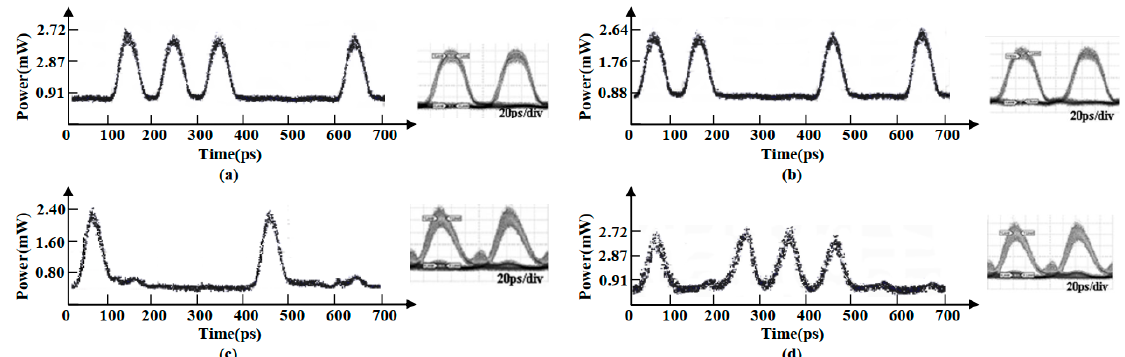
Figure 3. Wave from all-optical non-inverted parity generator ( a ) optical signal pulse train A , ( b ) optical signal pulse train B , ( c ) the odd parity bit output, ( d ) the even parity bit output.